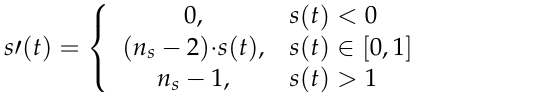
Table 2. Summary of RL approaches.